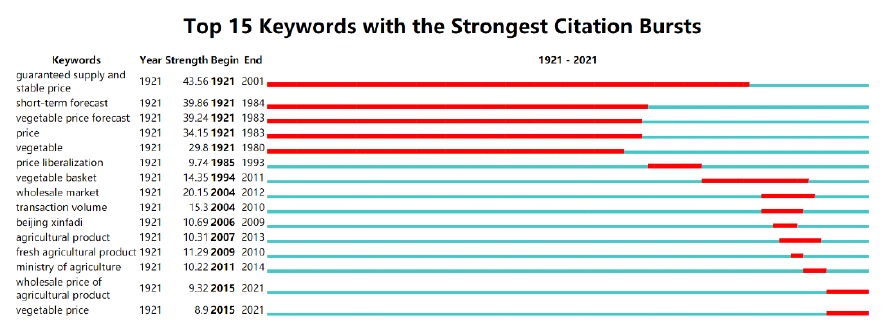
Figure 6. CNKI Keyword Co-occurrence Network Diagram.